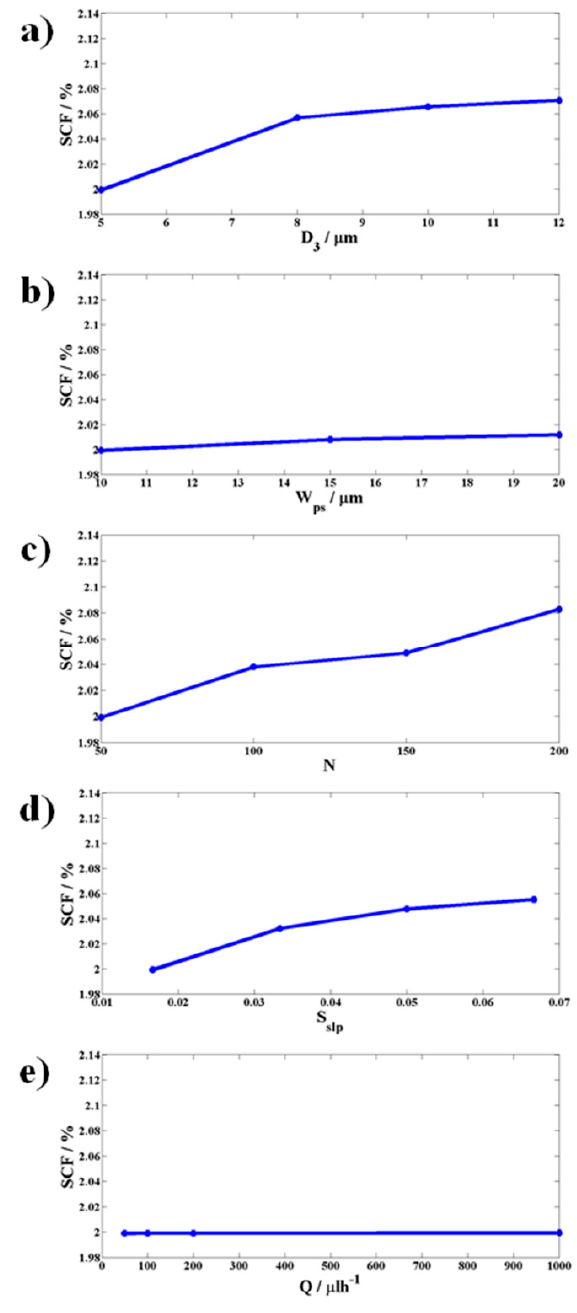
Figure 5. Each panel reports the trend of SCF . The simulation results showing the e ff ect of parameters of Section II, namely ( a ) height of the pillar ( D 3 ), ( b ) spacing between the pillars ( W ps ), ( c ) number of pillars ( N ), ( d ) slope of the side channel S ( S slp ), and ( e ) the sample flow rate ( Q ) on the side to central channel flow rate ratio ( SCF ), respectively. The results indicate there is no significant e ff ect of the parameters of Section II and the flow rate on SCF .